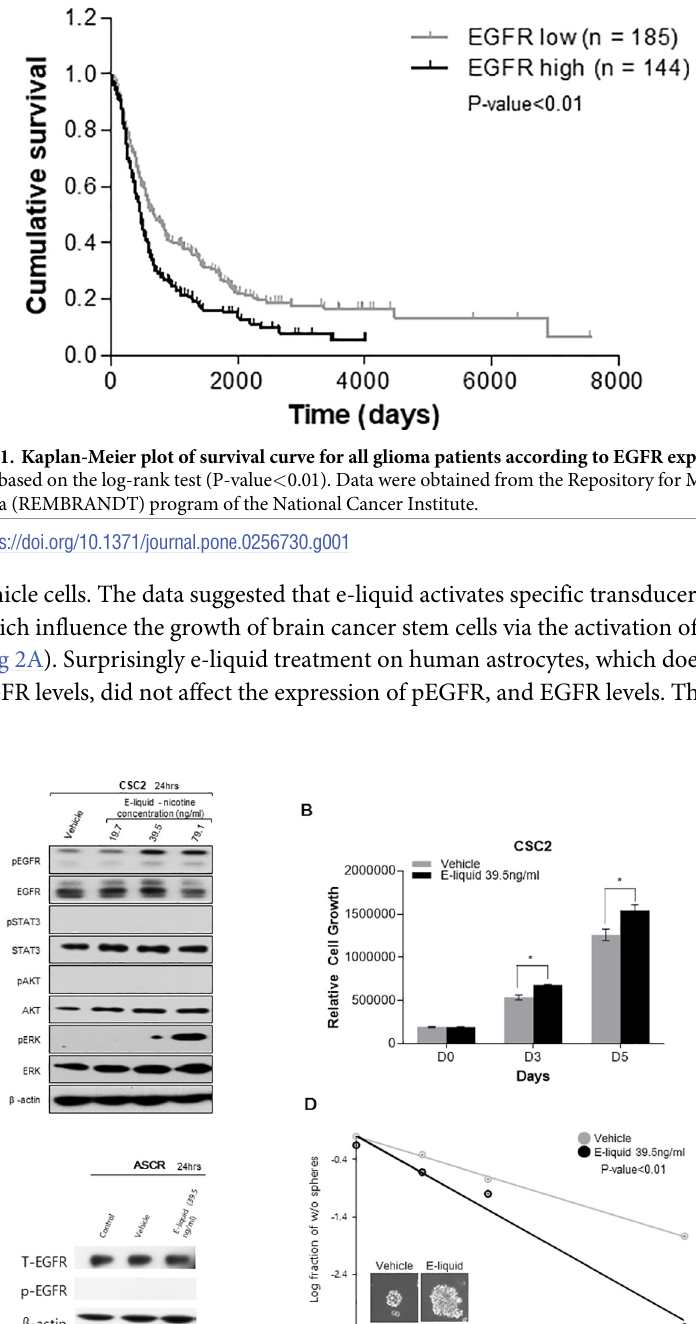
Fig 2. E-cigarette promotes EGFR activation in glioma stem cells (GSCs). (A) Western Blot analysis of pEGFR, EGFR, pERK and ERK in GSCs (CSC2 cells) treated with e-liquid or its vehicle. β -actin was used as a loading. (B) Cell viability assays of GBM patient-derived cells compared with control and e-liquid treatment concentrations of CSC2 (P- value < 0.05). (C) Western Blot analysis of pEGFR, EGFR, pERK and ERK in human astrocytes treated with e-liquid or its vehicle. β -actin was used as a loading. (D) Limiting dilution assay of GBM patient-derived cell (CSC2 cells) treated with e-liquid or its vehicle. (P-value <